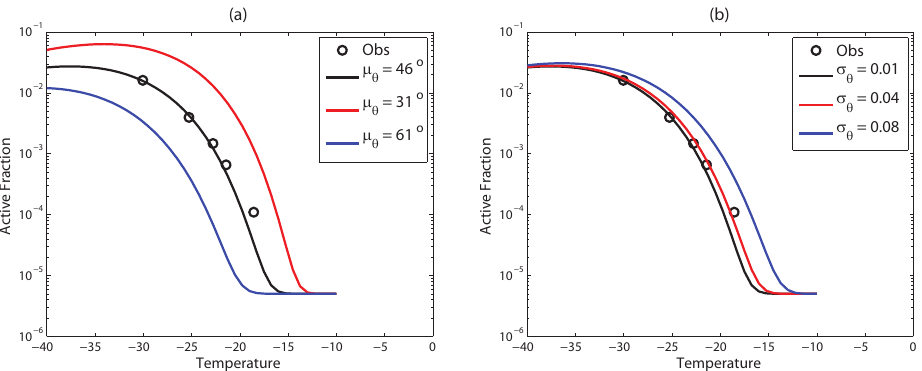
Figure 10. Active fraction as a function of temperature for the α -PDF model settings. Observation data are from CSU106 and the black solid line is its fit curve. The red and blue solid lines are sensitivity tests to (a) mean contact angle and (b) standard